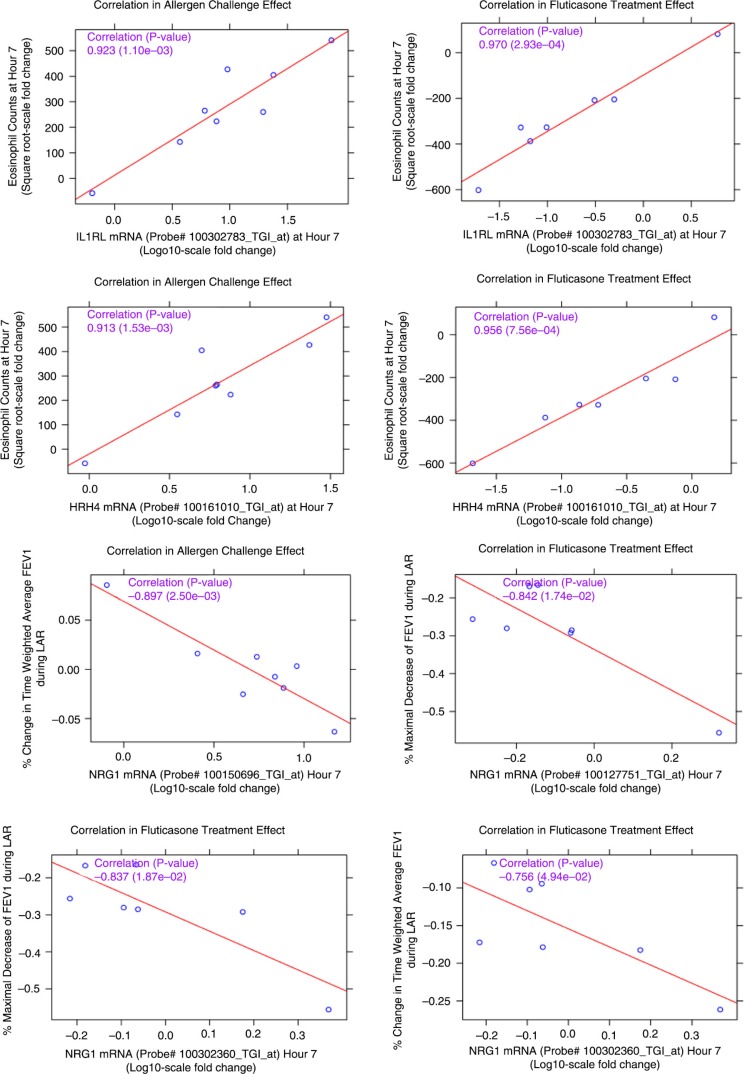
Correlation plots of the most significant probe sets to individual subject clinical measurements (sputum eosinophils and pulmonary lung function tests) for the allergen challenge effect and the FP treatment effect. Correlation coefficients and corresponding p values in parenthesis are listed in purple. HRH4: histamine receptor 4; IL1RL1: IL33 receptor; NRG1: neuregulin 1.